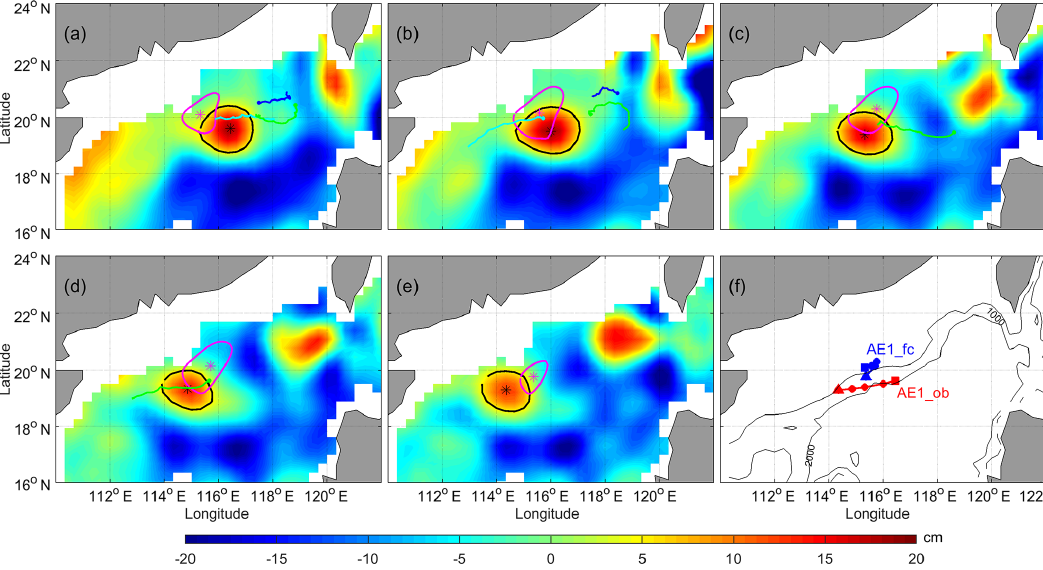
Figure 10. Same as Fig. 9, but for Exp3; the experiment period is the 31 December 2003 to the 30 January